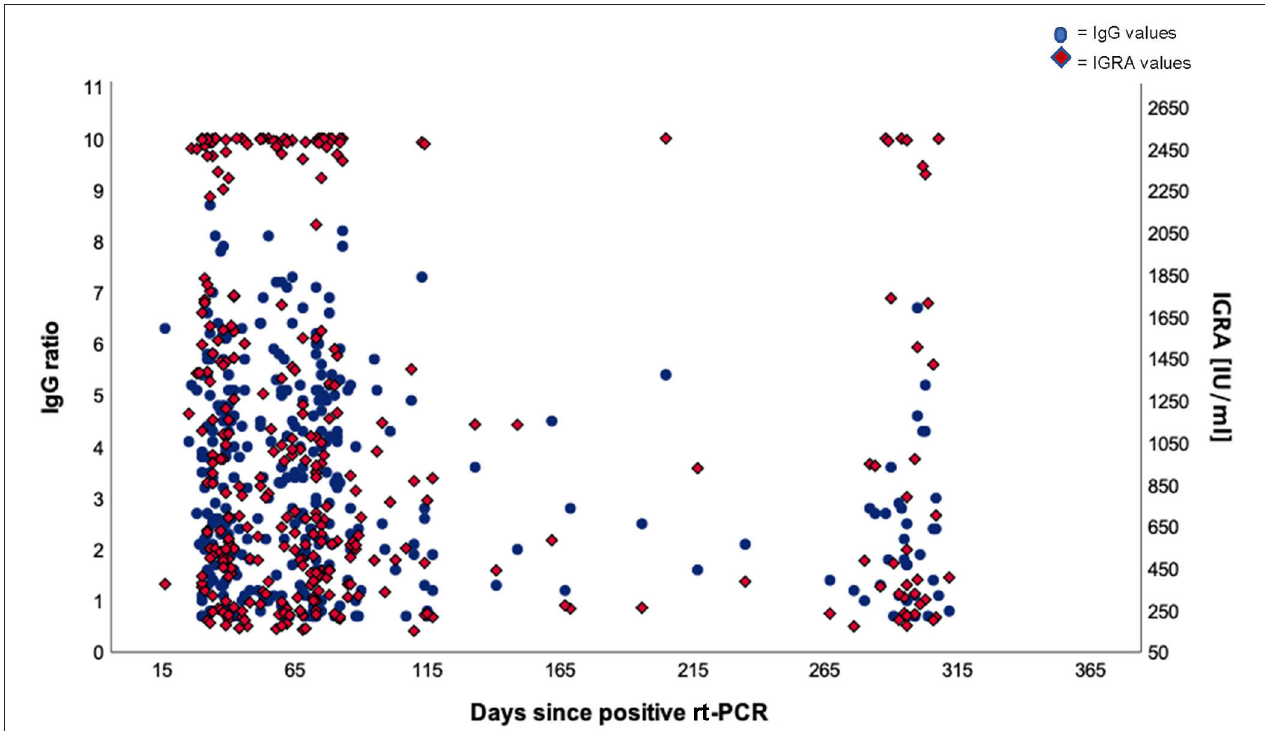
FIGURE 5 | Dual axis scatter plot for IgG ratios and IGRA values. The dots represent participants and their positive IgG values (cut-off at 1.1) and the diamonds represent participants and their positive IGRA values (cut-off at 200 mIU/ml).